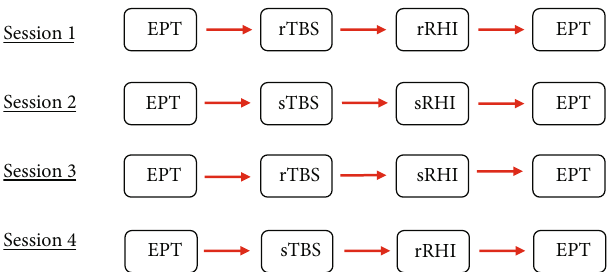
Figure 1: Study design: 4 sessions with a one-week interval. EPT: electrical perception test; rTBS: real theta burst stimulation; sTBS: sham theta burst stimulation; rRHI: real rubber hand illusion; sRHI: sham rubber hand